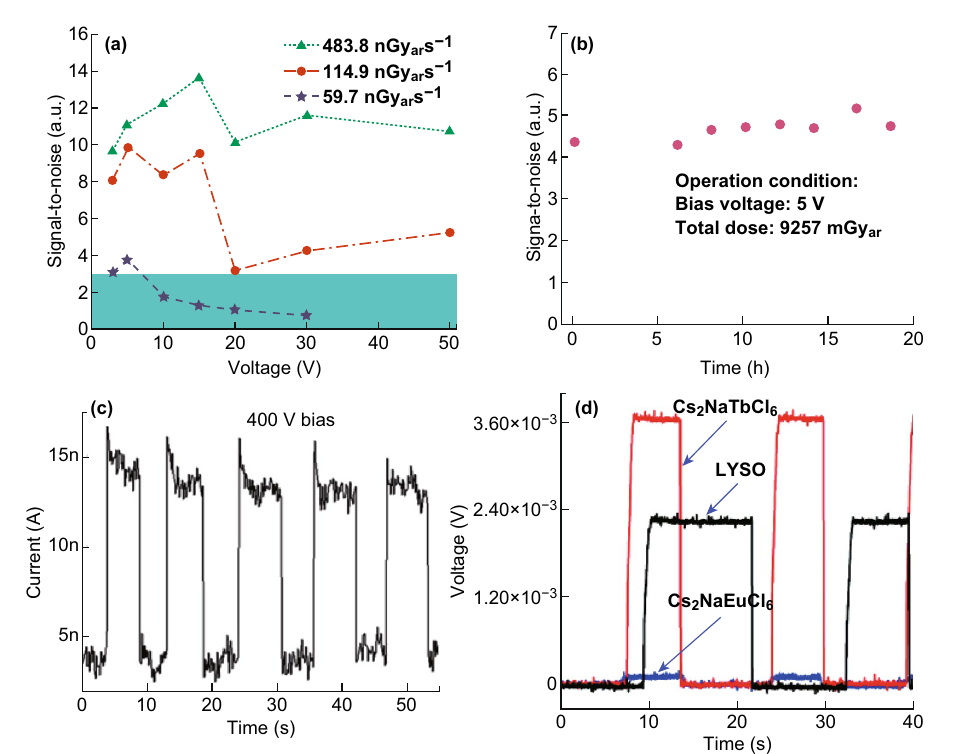
Fig. 5 a Signal-to-noise ratio of the device derived by calculating the standard deviation of the X-ray photocurrent. The red dashed line repre- sents a SNR of 3, and thus the detection limit is 59.7 nGyair s −1 at 5 V bias, as indicated by the purple star surrounded by the red dashed circle. b Operational stability of our Cs 2 AgBiBr 6 single-crystal X-ray detector. Testing conditions: continued 138.7 μGyair s −1 X-ray irradiation with constant 5 V bias, tested in ambient air without any encapsulation. Reproduced with permission from Ref. [54]. c Transient responses of the detector at a constant 400 V. Reproduced with permission [92]. d The generated voltage of multiplier tubes by scintillation light of Cs 2 NaTbCl 6 (red line), Cs 2 NaEuCl 6 (blue line) and (Lu,Y) 2 SiO 5 :Ce 3+ (LYSO, black line), respectively (color online). Reproduced with permission from Ref. [93]. (Color figure